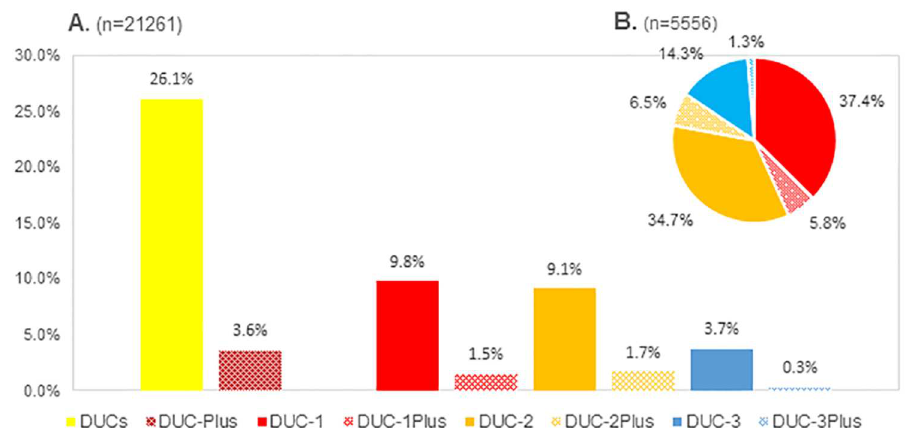
Fig 1. DUCs incidence and ratio. (A) DUCs incidenceper embryo. (B) DUCs ratio in DUC embryos. DUC-1: direct unequalcleavageat 1st cleavage;DUC-1Plus: DUC occur more than once in DUC-1 embryos; DUC-2: direct unequalcleavageat 2nd cleavage;DUC-2Plus: DUC occur more than once in DUC-2 embryos; DUC-3: direct unequalcleavageat 3rd cleavage;DUC-3Plus: DUC occur more than once in DUC-3 embryos; Non- DUC: embryos without DUC; DUC-Plus: DUC occurred more than once (DUC-1Plus, DUC-2Plus and DUC- 3Plus combined);DUCs: All DUC